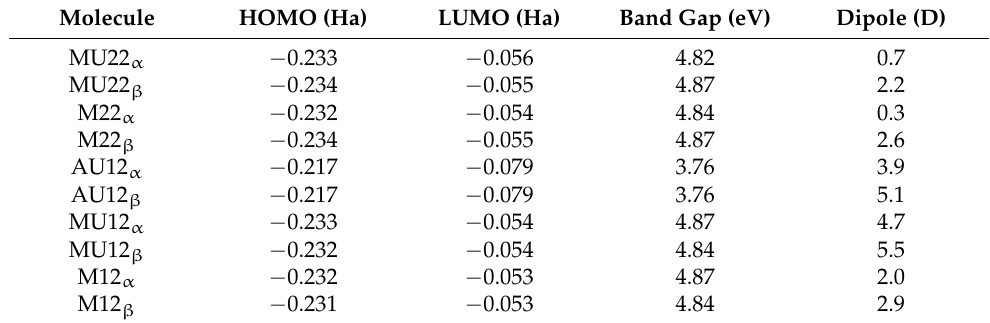
Table 4. HOMO and LUMO energy and band-gap values for the selected conformations of the studied